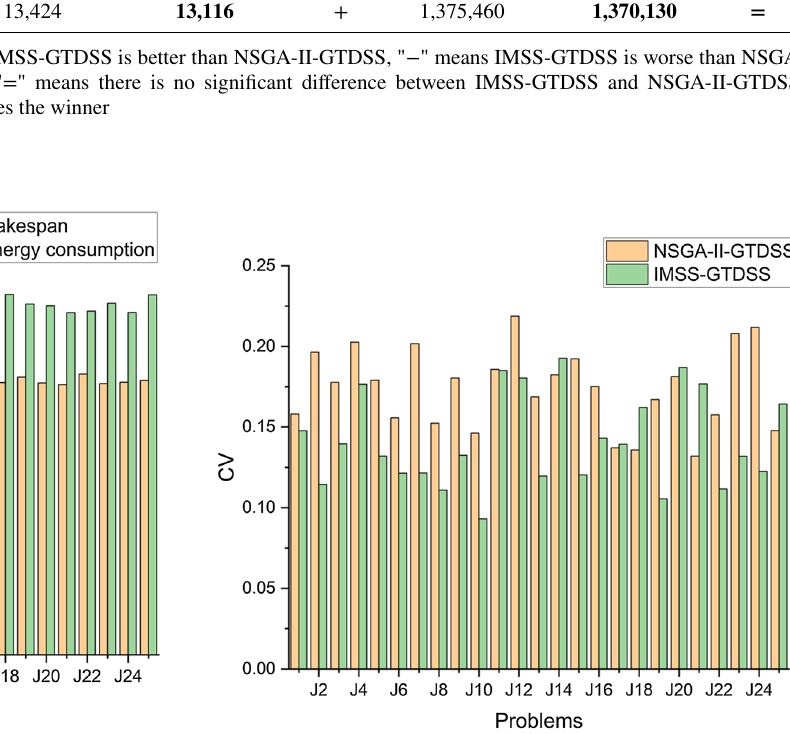
Fig. 15 The CV of IMSS-GTDSS and